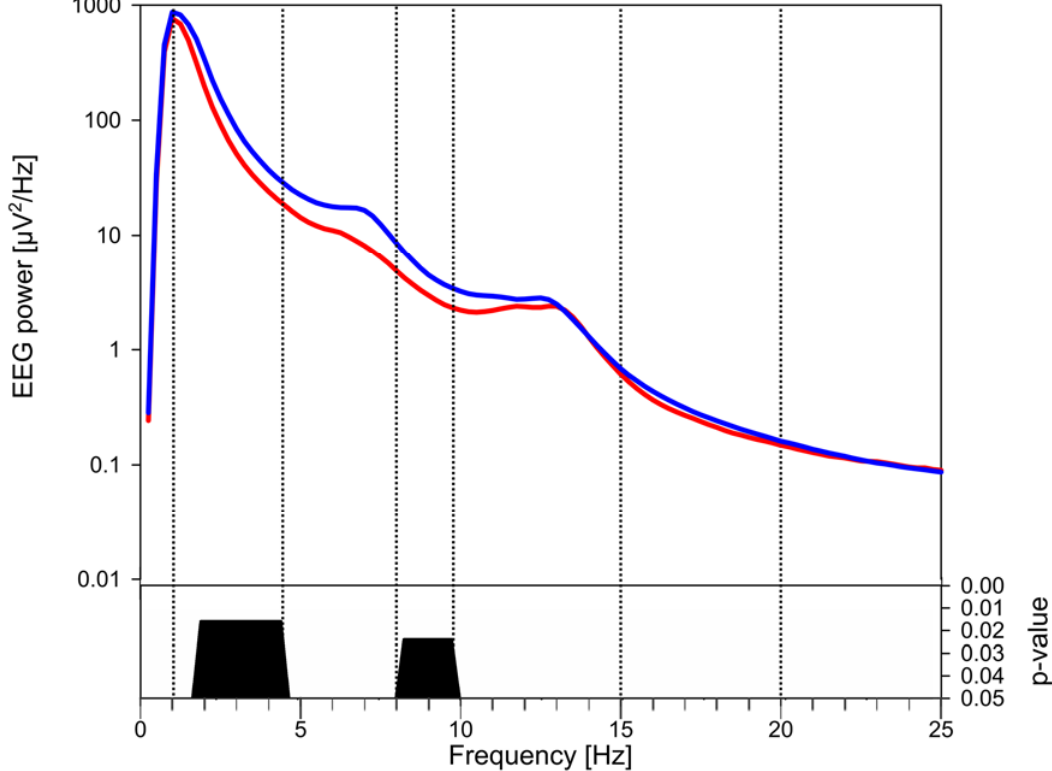
Figure 1. Power spectrum of the sleep electroencephalogram (EEG) in caffeine consumers (red, n = 16) and controls (blue, n = 16). Group-wise comparisons were performed with the first two hours of NREM sleep EEG data using the average across all 109 electrode channels for each subject within each frequency bin within 0.25 and 25 Hz. Commonly used EEG frequencies are separated by vertical lines: SWA = 1–4.5 Hz; theta = 4.75–7.75Hz; alpha = 8–9.75 Hz; beta = 20–25 Hz. Frequency bins (0.25-Hz) within which power differed significantly ( p < 0.05; two-tailed, unpaired Student’s t -test) and the level of their significance are shown in the lower panel, only significant p values (after FDR correction) are